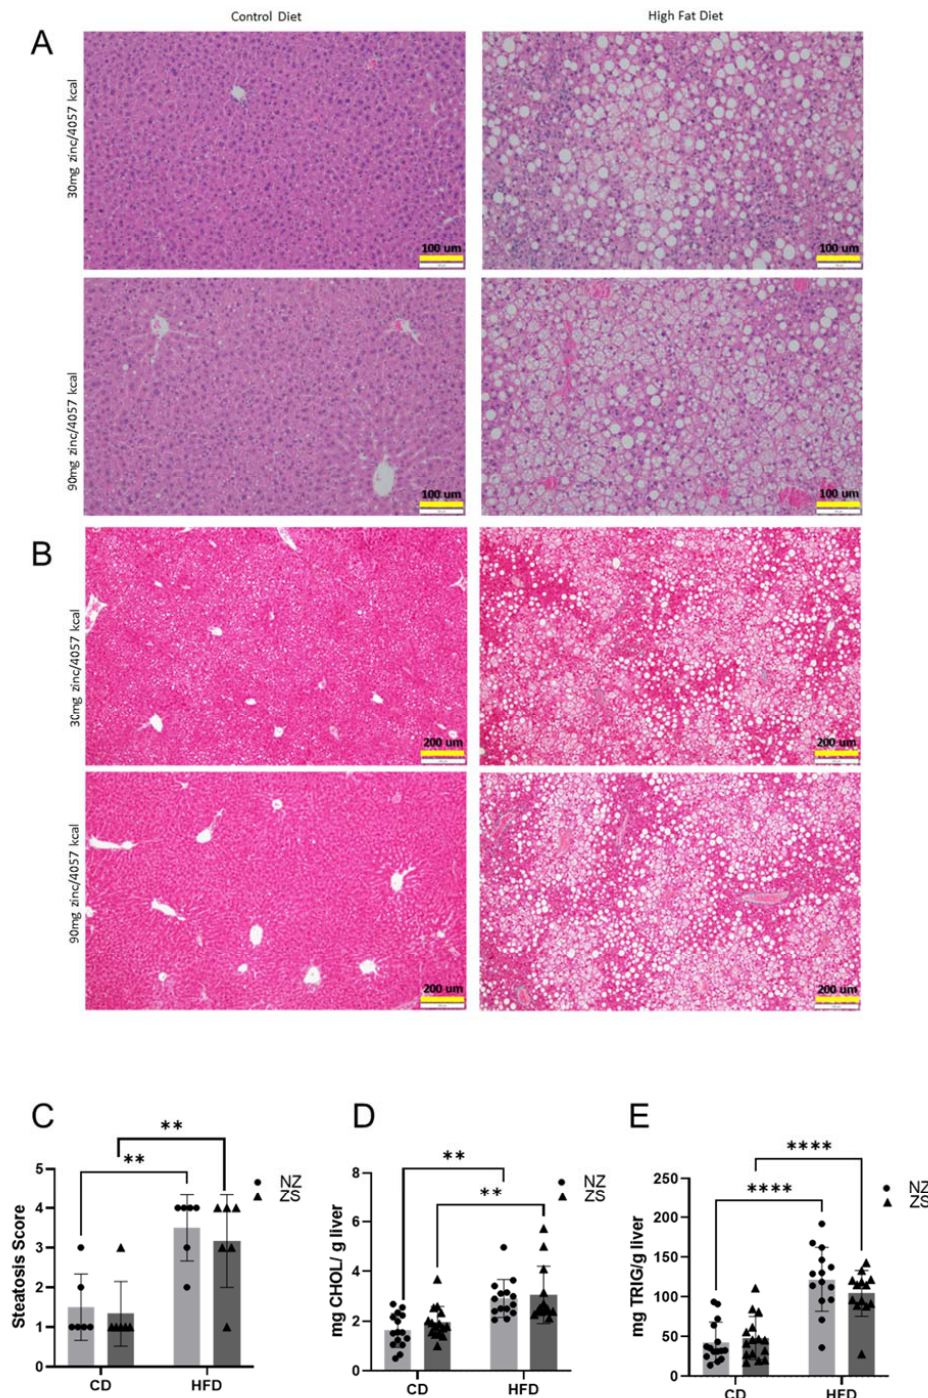
Figure 6. Effects of HFD and zinc supplementation on hepatic steatosis. Zinc supplementation did not attenuate HFD-induced steatosis nor increase hepatic triglycerides or cholesterol. 5 µ m liver tissue sections stained by ( A ) H&E (20 × ) and ( B ) Masson Trichrome (10 × ) showed hepatic morphology and macrovascular steatosis or collagen deposition, respectively. ( C ) Steatosis was scored as percentage of liver cells in 10, 10 × field per liver containing fat. ( D ) Hepatic levels of cholesterol (CHOL) and ( E ) triglycerides (TRIG). Data are reported as mean ± SD (n = 6 mice/group, C; n = 14–15 mice/group, D , E ) with significance set to 0.05. ** p < 0.05, **** p < 0.0001. CD = control diet, HFD = high fat diet, NZ = normal zinc, ZS = zinc